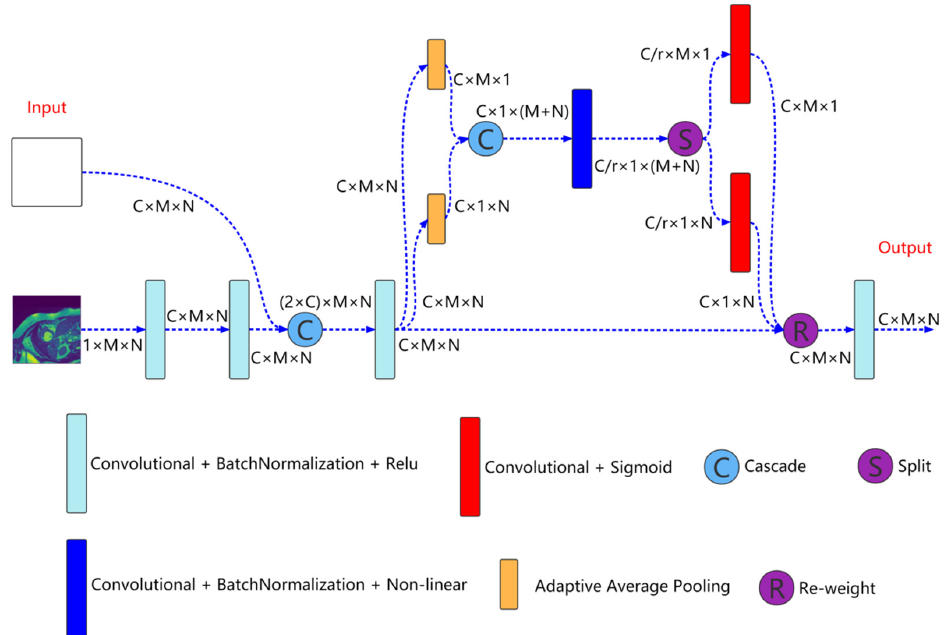
Figure 2. Multiresolution aggregation module structure. M = H /2 n , N = W /2 n , C , and r represent the number of channels and reduction rate, respectively.